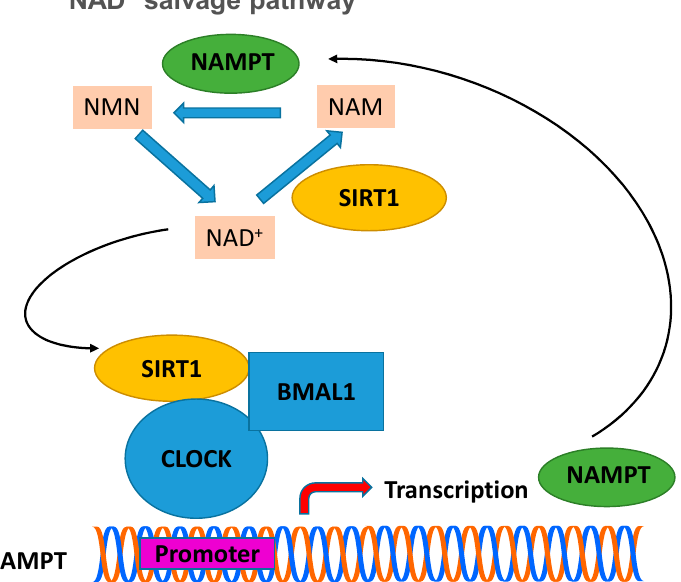
Figure 5. The circadian clock machinery regulates the biosynthesis of NAD + through control of the NAD + salvage pathway. BMAL-1:CLOCK heterodimer binds to the promoter region of NAMPT to regulate the rhythmic transcription of this gene and thus the levels of NAD + . Expression of SIRT1 silences the expression of NAMPT (the rate-limiting enzyme in NAD + biosynthesis), which leads to a decrease in the concentration of NAD + , diminishing the activity of SIRT1. When the activity of SIRT1 decreases significantly, then the activity of CLOCK:BMAL-1 begins to increase, which restores the expression levels of NAMPT and thus completes the cycle. NAMPT: nicotinamide phosphoribosyltransferase; CLOCK: basic helix-loop-helix-PAS transcription factor; BMAL1: Brain and muscle ARNT-like 1 protein; NMN: nicotinamide mononucleotide; NAM: nicotinamide.